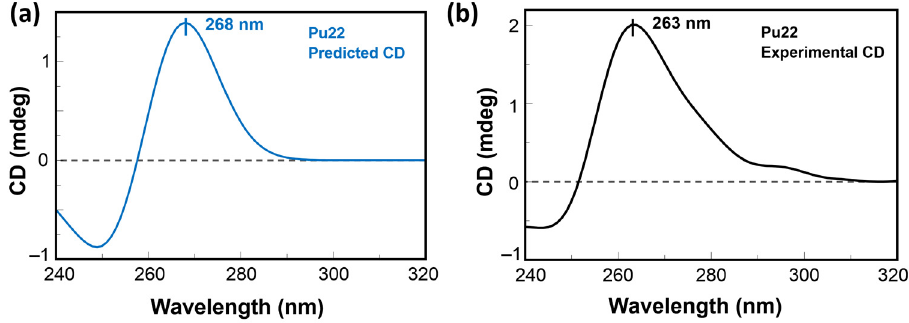
Figure 6. Theoretical CD spectrum of Pu22 G4 ( a ) as simulated by DichroCalc [45] using the PDB ID 1XAV, compared with the experimental counterpart ( b ) obtained for Pu22 at 2.5 μ M in PBS.